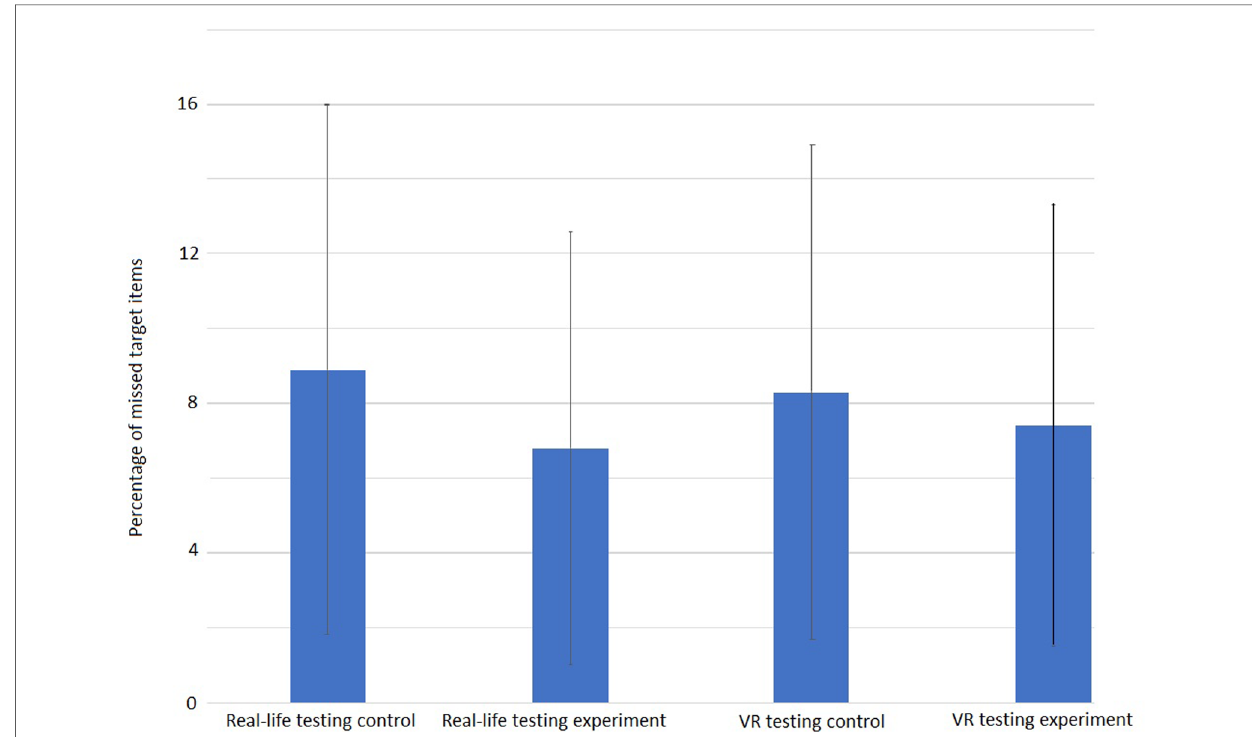
FIGURE 6 Average accuracy of performance in the D2-test of attention shown as percentage of missed target items. In Real-Life testing (left) 8.9%, under control conditions (SD 7.1) vs. 6.8% (SD 5.8) during experimental conditions while in the VR-Testing, under control conditions 8.3% of target items were missed (SD 6.6) vs. 7.4% (SD 5.9) under experimental conditions. No statistically signi fi cant difference between conditions was found (Real-Life: t (8)=1.052; p =0.324, VR: t (7)=1.42; p